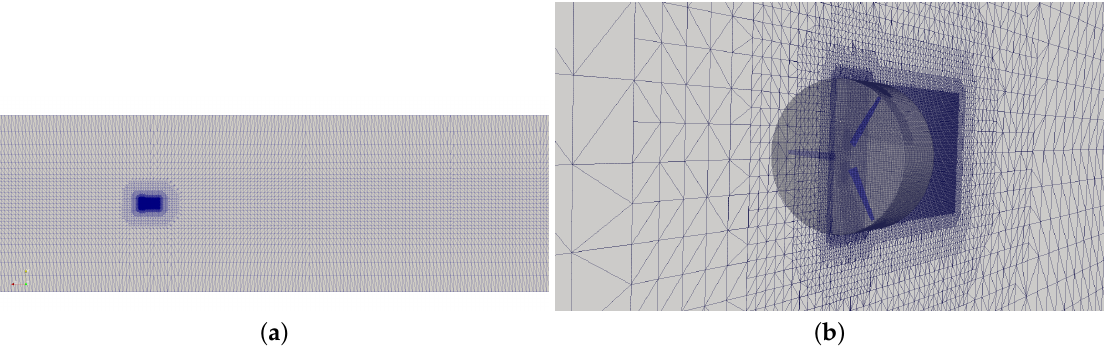
Figure 2. Freestream mesh. ( a ) The whole domain. ( b ) The mesh near the freestream turbine with the wake refinement and the cylindrical